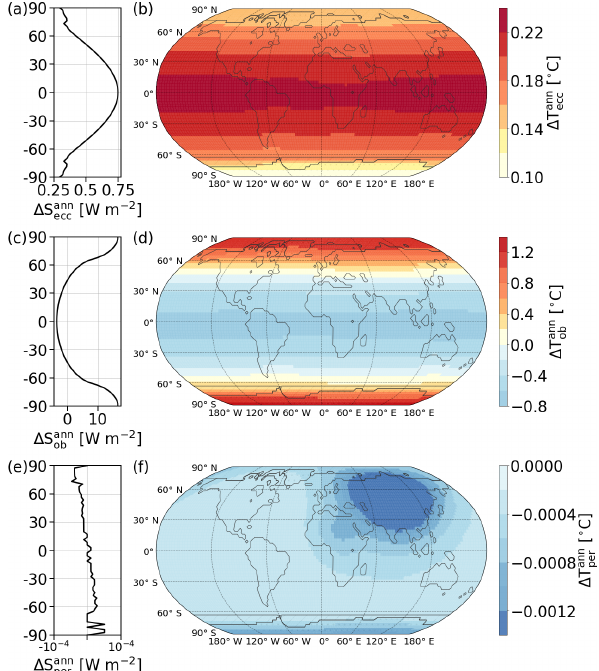
Figure B2. Annually averaged difference in solar insolation (left) and temperature (right) caused by extremes in the orbital parameters as listed in Table 3 for eccentricity (a, b) , obliquity (c, d) , and pre- cession of the perihelion (e, f) . Model configuration is the same as in Fig. 14. Obliquity changes produce the largest difference, whereas the precession of the perihelion averages out throughout the year and has no effect on annual averages. Both eccentricity and obliq- uity show symmetric patterns. However, eccentricity affects the low latitudes the most, while the difference in the obliquity experiments grows